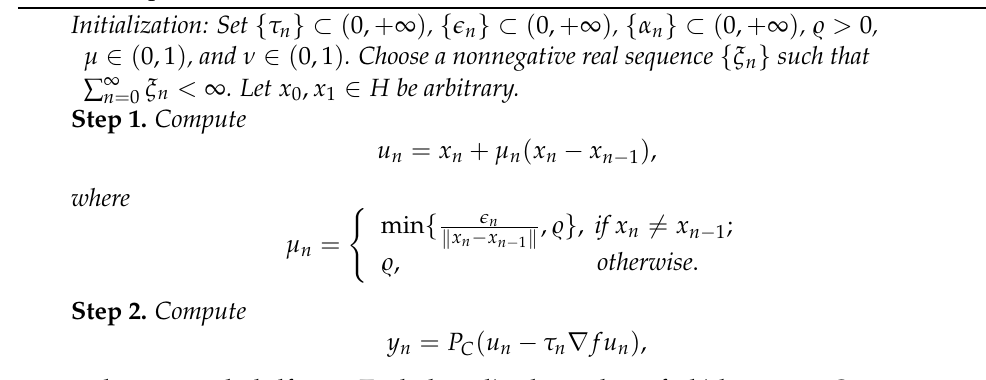
Algorithm 5: Modified inertial subgradient extragradient method to split mini- mization problems